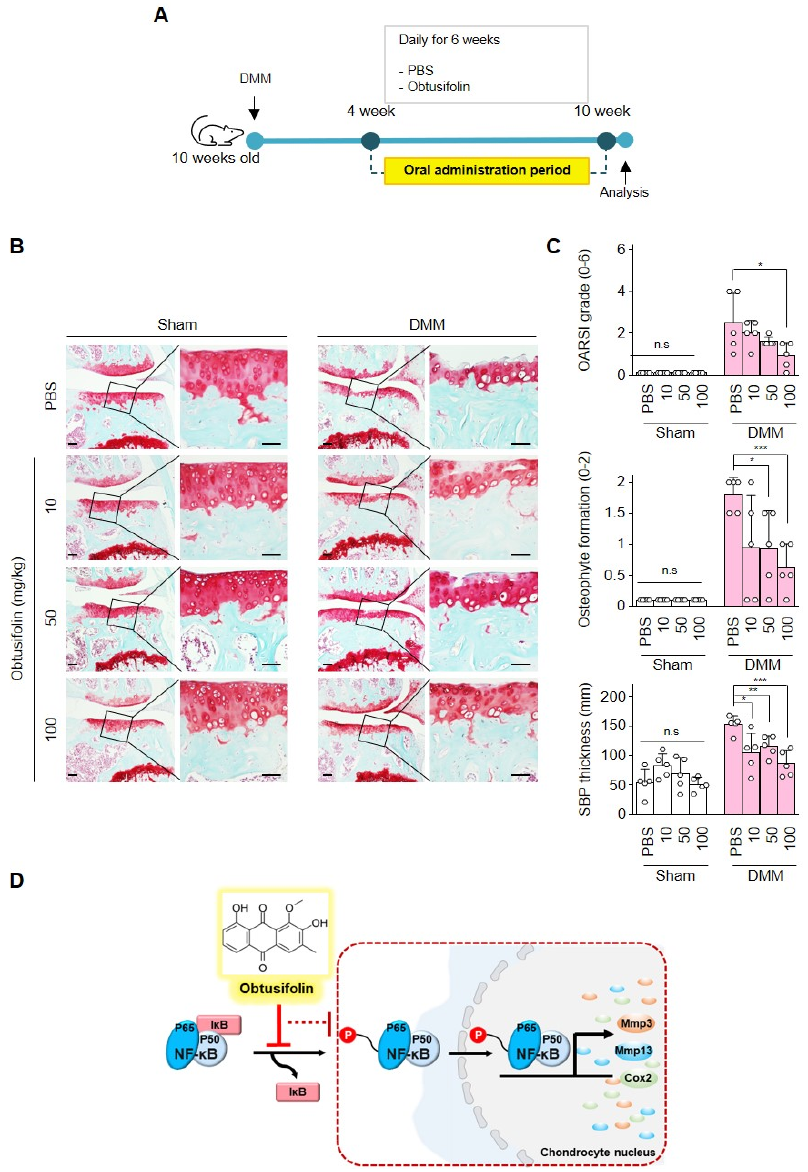
Figure 4. Oral administration of obtusifolin inhibits cartilage degradation. DMM(Destabilization of the medial meniscus)-induced osteoarthritic (OA) mice were administered PBS or obtusifolin (10, 50, and 100 mg/kg) daily for 6 weeks after 4 weeks of surgery ( A ). Safranin O staining shows the degree of cartilage destruction ( B ). Scale bar: 50 μ m (left) and 100 μ m (right). Cartilage destruction was scored by Osteoarthritis Research Society International (OARSI), subchondral bone thickness, and osteophyte formation ( C ). A graphical summary of the inhibition mechanism of obtusifolin ( D ). Data were analyzed using the one-way ANOVA and Student’s t -test. Values of each group ( n = 5) are shown as mean ± SEM; * p < 0.05, ** p < 0.01, and *** p < 0.001. MMPs and Cox2 induce cartilage destruction and inflammation in OA [3,5]. These catabolic factors are primarily activated downstream of proinflammatory cytokines [5,6].